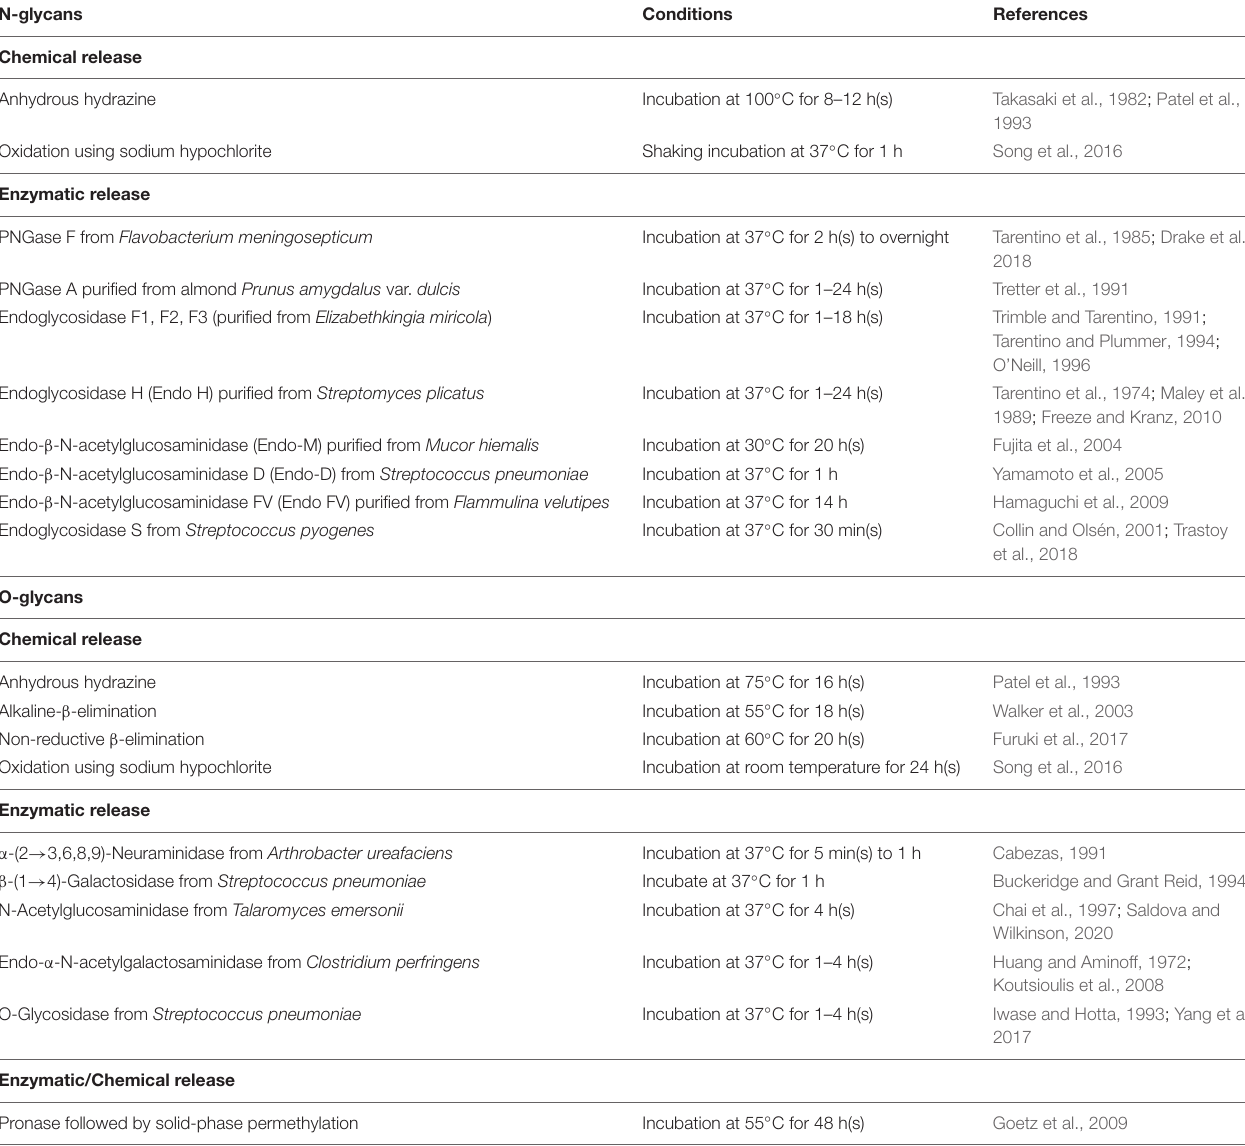
TABLE 1 | Chemical and enzymatic deglycosylation methods for